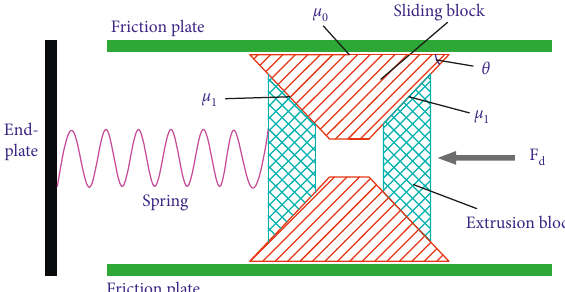
Figure 2: Schematic of the passive variable friction